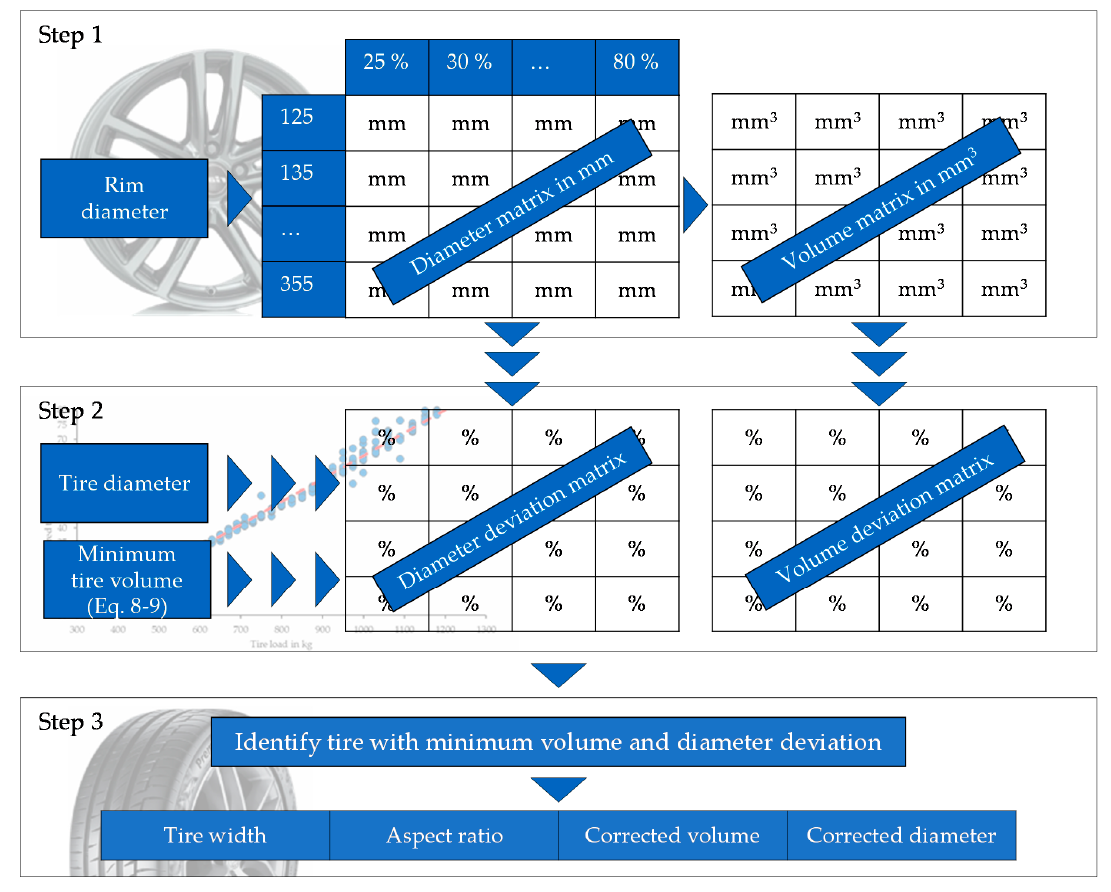
Figure 2. Overview of the correction method for the tire dimensions.